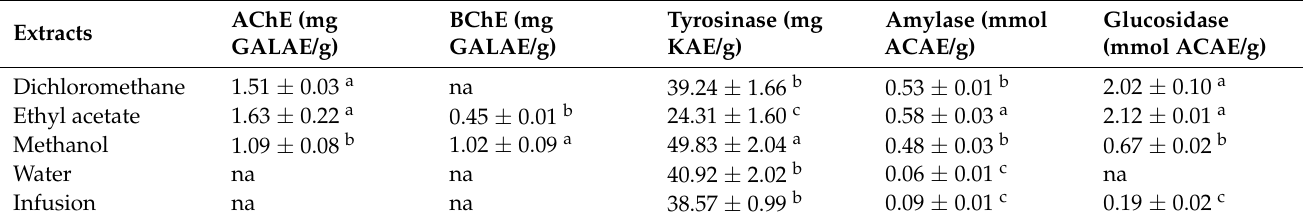
Table 3. Enzyme inhibitory effects of the tested extracts